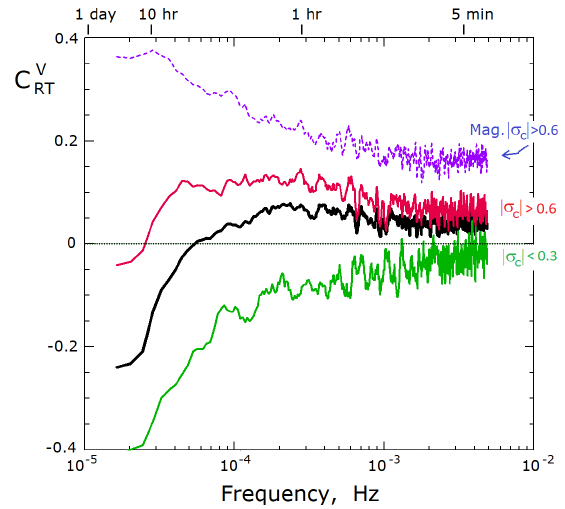
Figure 6. Correlation between radial (R) and tangential (T) com- ponents of velocity is shown with black line . Green and red lines exhibit the same, but calculated separately for time intervals with small and high alfvénicity; blue dashed line indicates for compar- ison correlation between R- and T-component of magnetic fluctua-